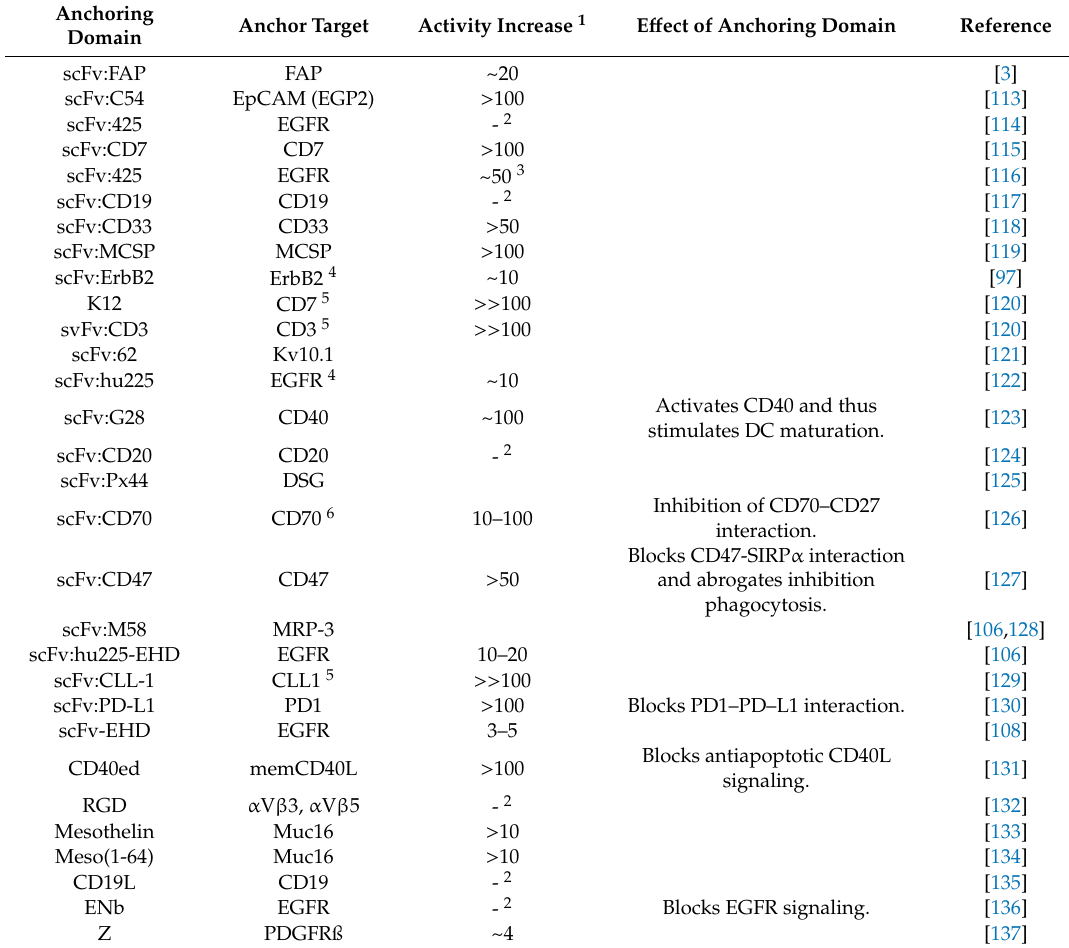
Table 5. Soluble TRAIL fusion proteins with cell anchoring-restricted activity. Fusion proteins, for which it is unclear whether their enhanced activity is due to cell anchoring or oligomerization, are not listed (e.g., IL2-TRAIL, ref. [111]; TMPT1-sTRAIL, Ref.